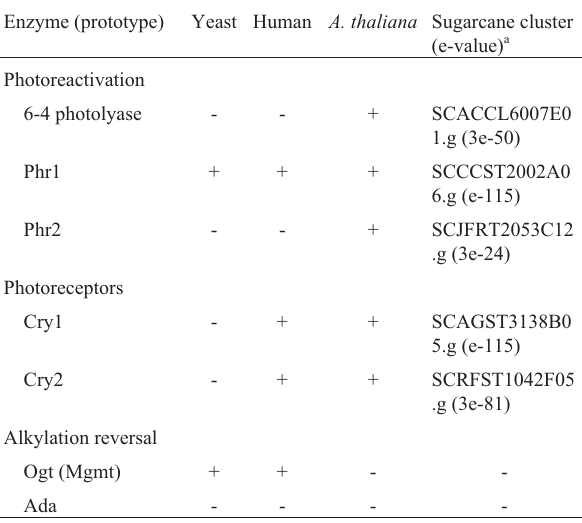
Table I - Direct repair related proteins and their homologues in different